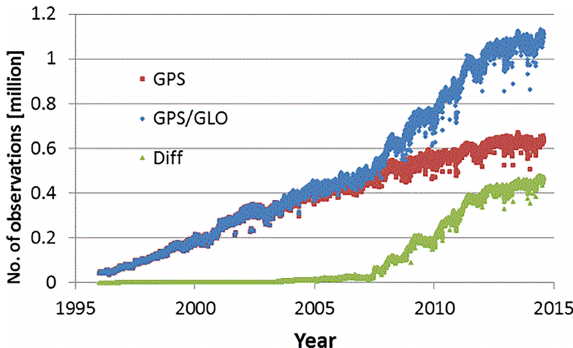
Figure 1. Time series of the number of GNSS observations for the period 1996–2014. GPS observations are shown in red, GPS/GLONASS in blue and their differences in green. The differ- ence becomes significant starting from